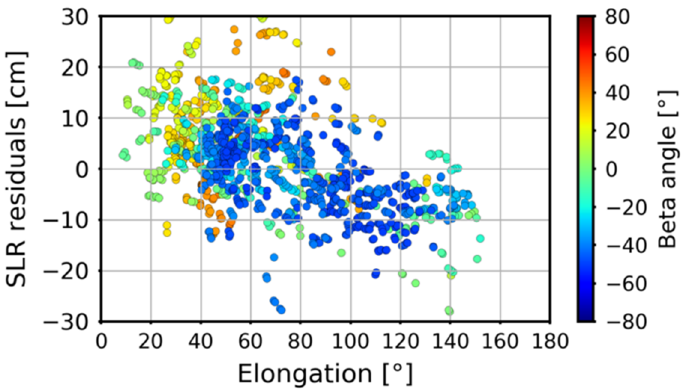
Figure 6. Distribution of the SLR residual with respect to the Sun elongation angle ( ϵ ) for C13 orbits determined with the ABW model plus a constant acceleration along the X direction.